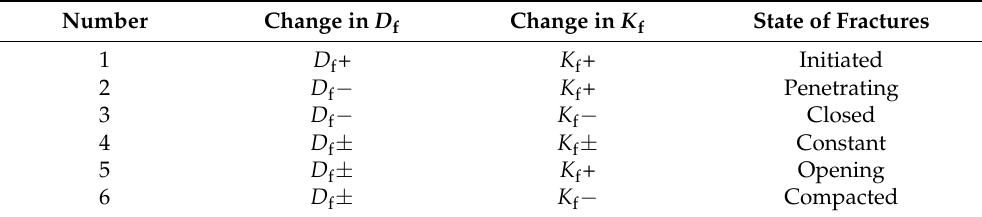
Table 3. Criteria for determining the spatiotemporal state of rock mass fractures due to mining. Number Change in D f Change in K f State of